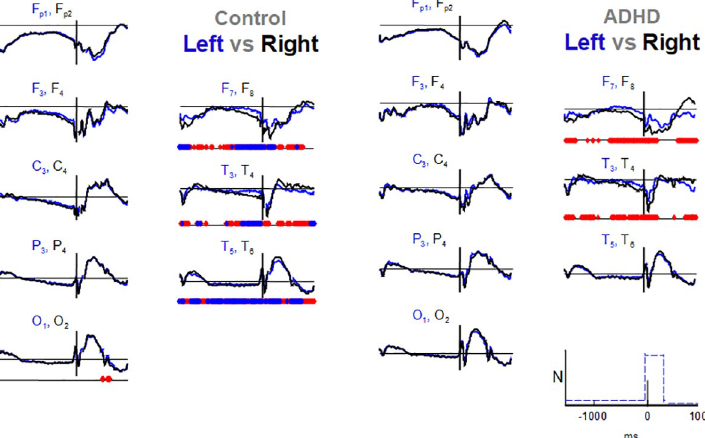
Fig 3. Comparisons of the ANT-related potentials between hemispheres, for all conditions. Blue and black for left and right hemispheres, respectively, by groups, and amplitudes are normalized (N at scales in the lower right corner, positive values above abscissae). Significance level of point-to-point comparisons with FDR-corrected scanning is marked on the parallel abscissae (time axis) below the graphs of each wave pair (blue rhombs, p � 0.01; red rhombs, p � 0.05). See Fig 2 for channel